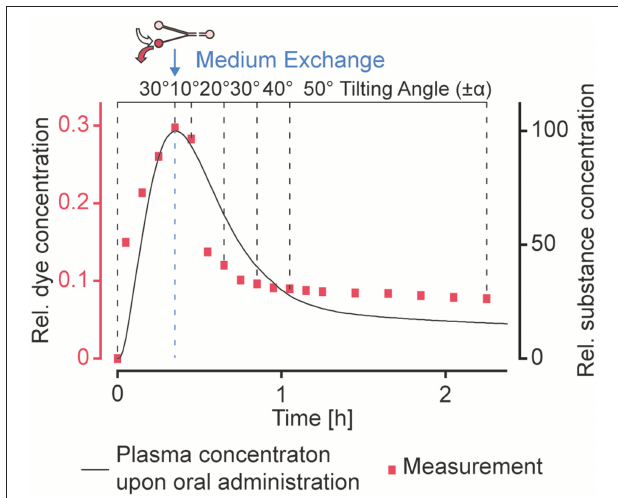
FIGURE 7 | Realization of more complex dosing profiles. A typical concentration profile ( Kwon, 2001) upon oral administration of a substance could be approximated by using a sequence of different tilting angles. A medium exchange to replace the substance-loaded medium in the reservoir connected to the narrow channel with plain medium was performed after ∼ 20min. Amaranth red dye was used as